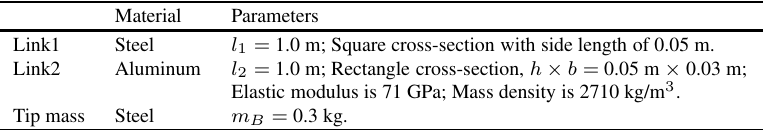
Table 1 Parameters of the two-link flexible robotic